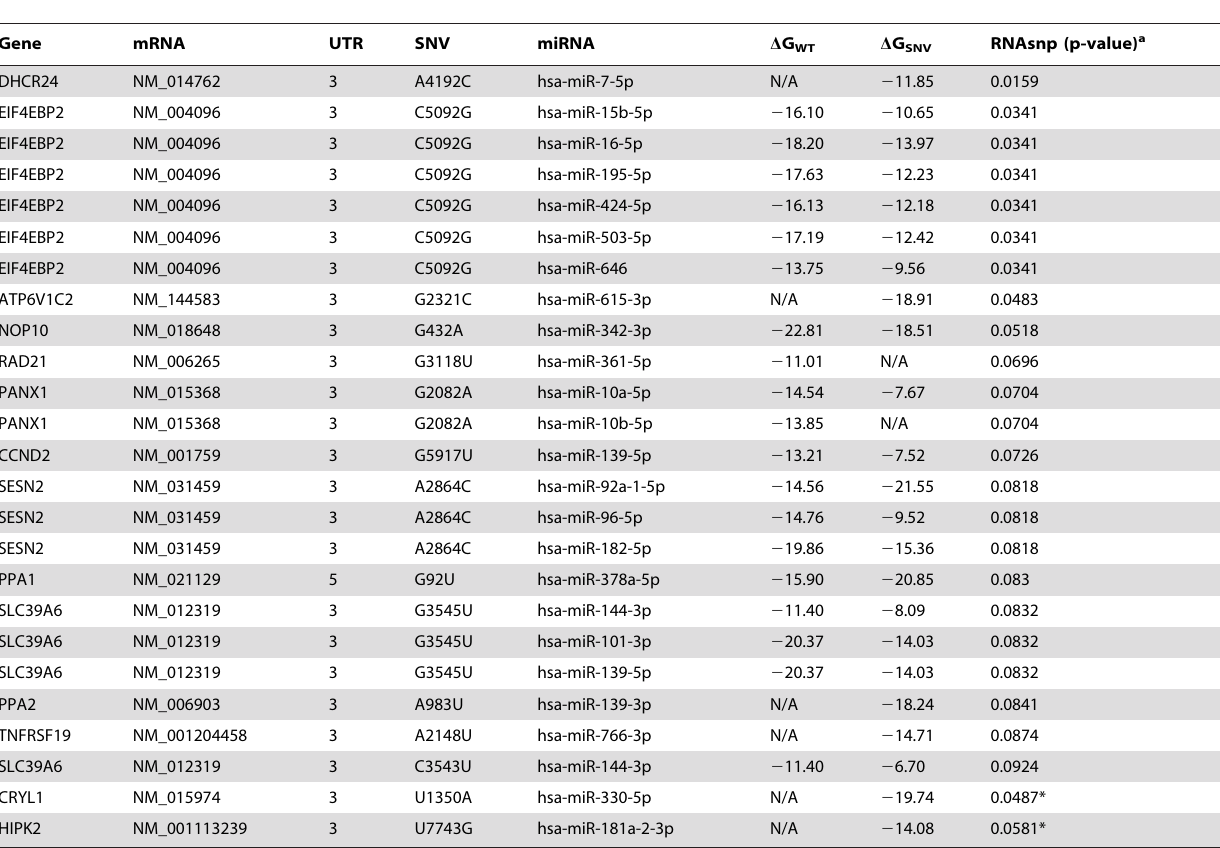
Table 6. List of predicted miRNA target site changes that overlap with RNAsnp predictions.